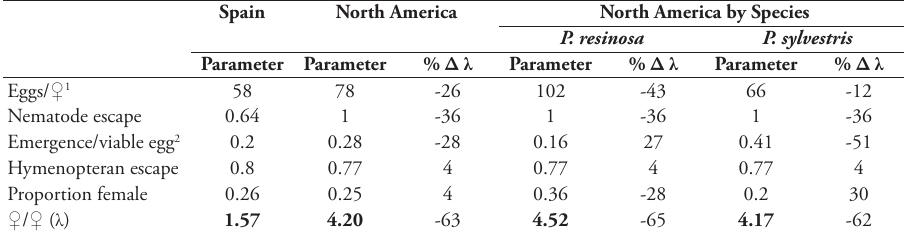
1 eggs/female calculated as the number of eggs expected in an average sized (20 mm) female; 2 calculated, based on egg estimates in Madden